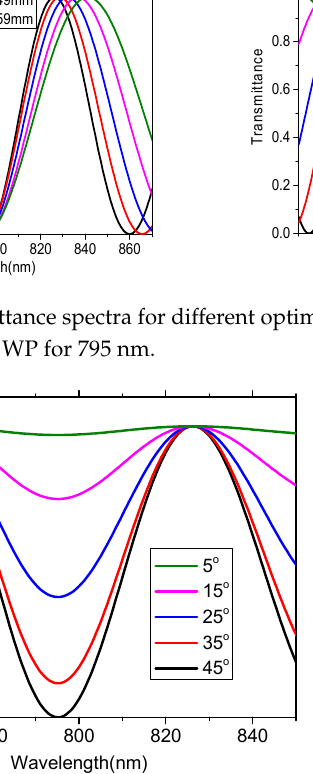
Figure 2. The transmittance spectra of a 1.117 mm thickness WP for different rotation angles.